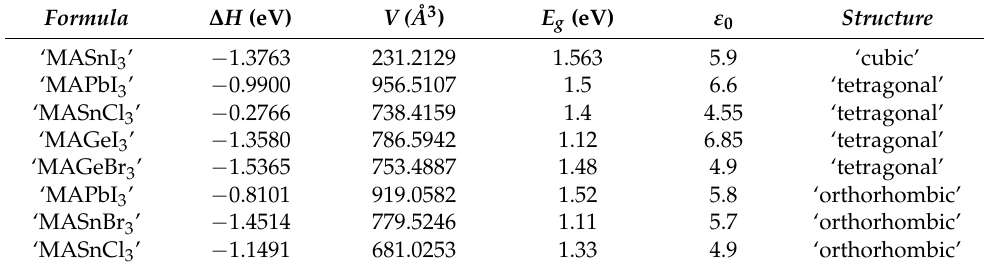
Table 1. The best 16 compounds that have the appropriate range of photovoltaic bandgap values: (1.1 eV < E g < 1.6